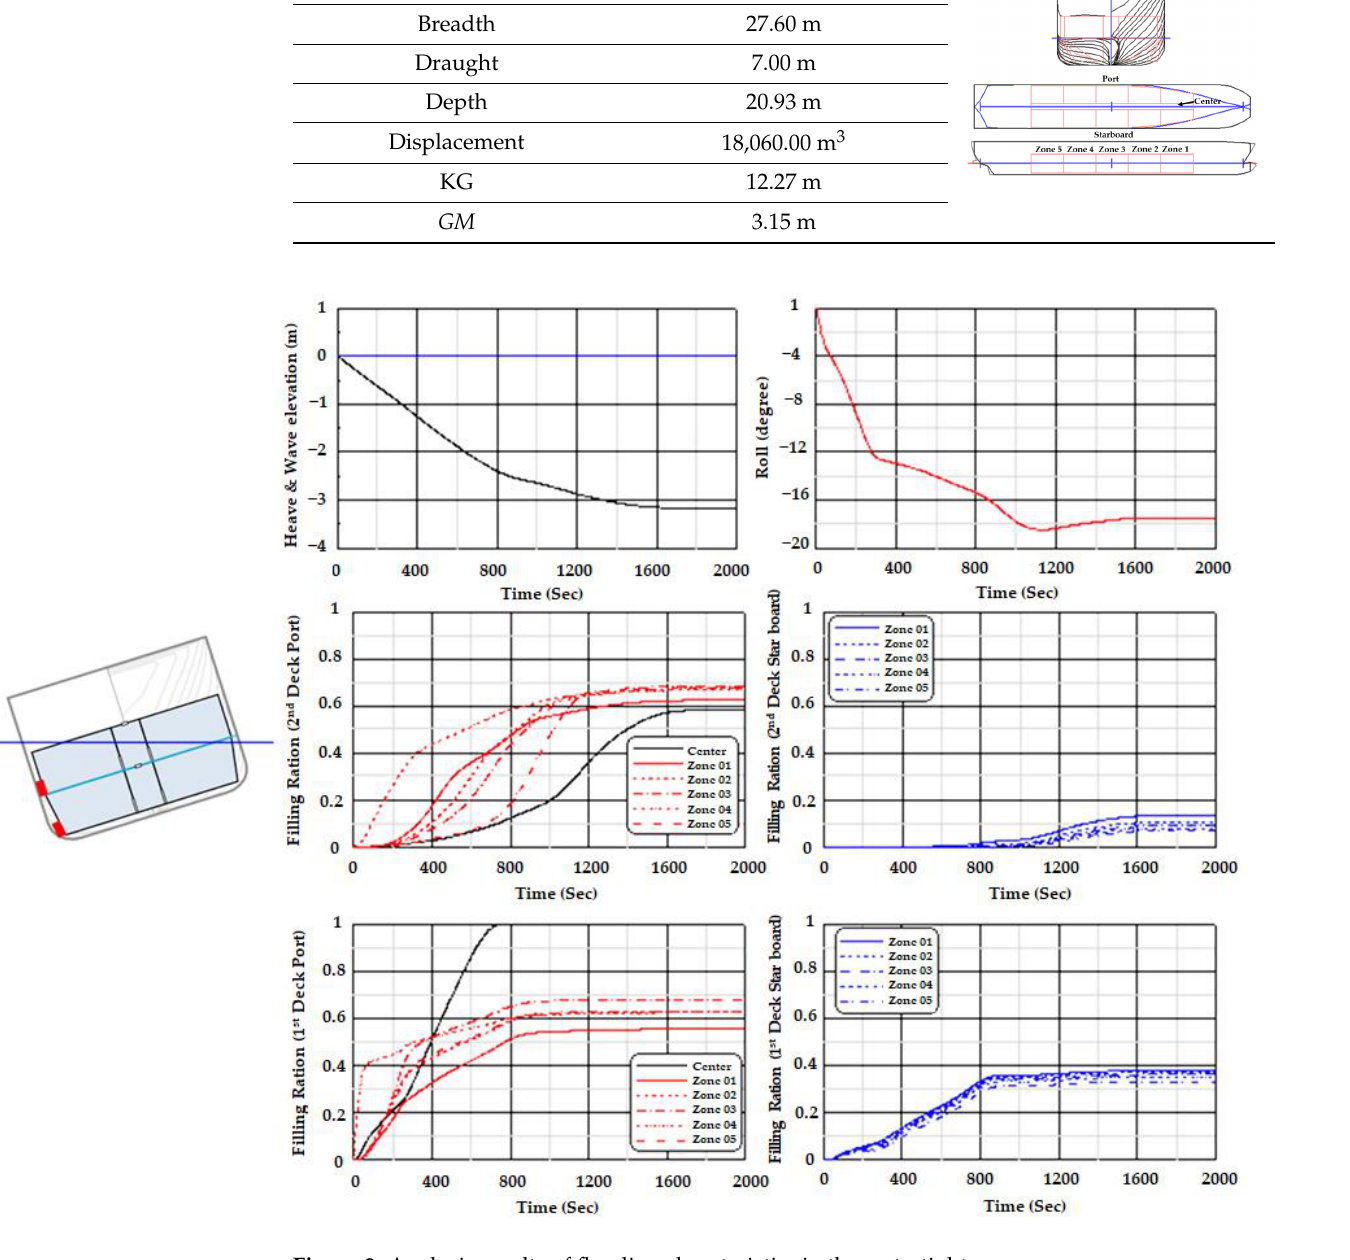
Figure 3. Analysis results of flooding charateristics in the watertight area.